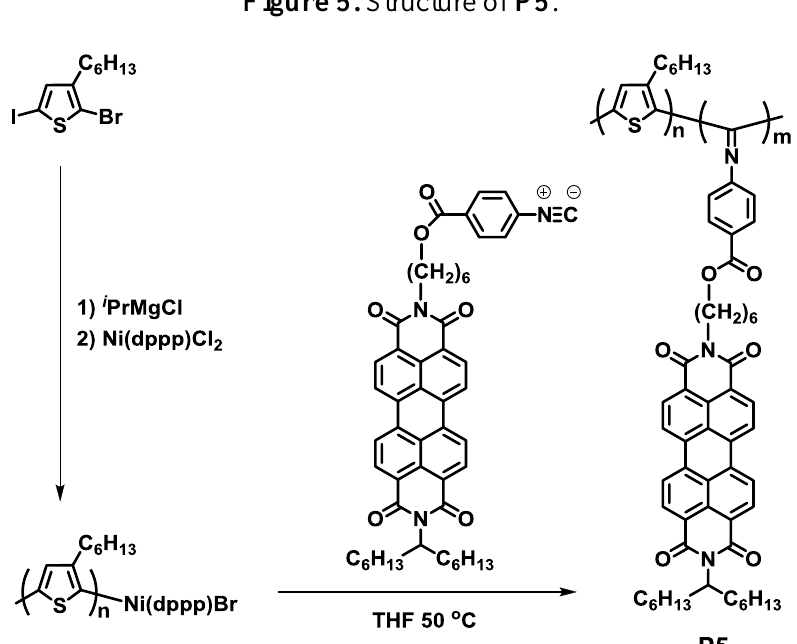
Figure 5. Structure of P5 .